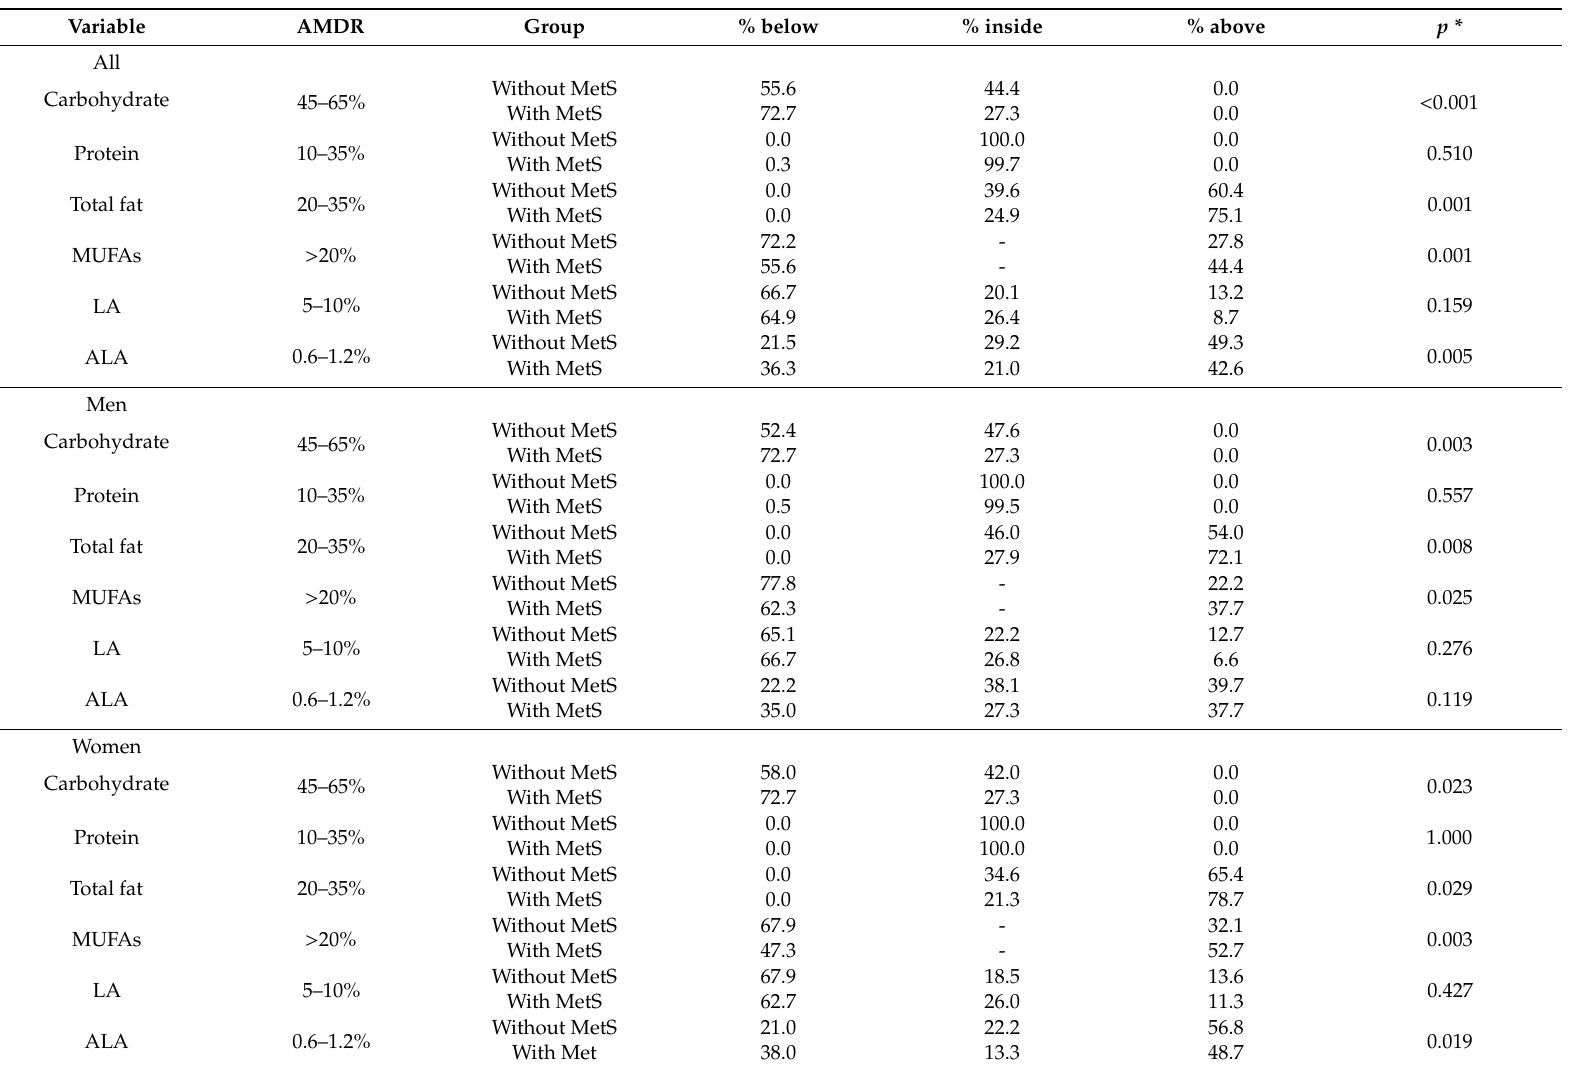
Table 4. Percentage of participants “with Metabolic Syndrome” and “without Metabolic Syndrome” below, inside, and above Acceptable Macronutrient Distribution Range (AMDR) proposed by the Institute of